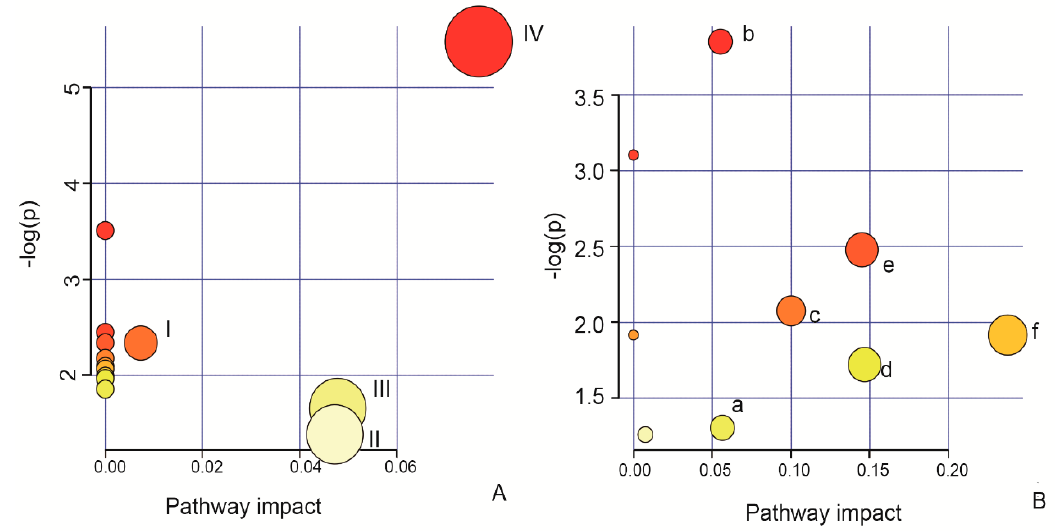
Figure 6. Results of the pathway analysis of the potential biomarkers in cells and cell culture supernatants. ( A ) Effect of AEE on possible metabolic pathways in the absence of H 2 O 2 . I: Phenylalanine, tyrosine and tryptophan biosynthesis; II: tyrosine metabolism; III: cysteine and methionine metabolism; and IV: valine, leucine and isoleucine biosynthesis. ( B ) Effect of AEE on possible metabolic pathways disturbed by H 2 O 2 . a: Aminoacyl ‐ tRNA biosynthesis; b: cysteine and methionine metabolism; c: lysine biosynthesis; d: lysine degradation; e: riboflavin metabolism; and f: glutathione metabolism. Table 3. The effect of AEE on the levels of potential biomarkers in cell and cell supernatants stimulated with H 2 O 2.